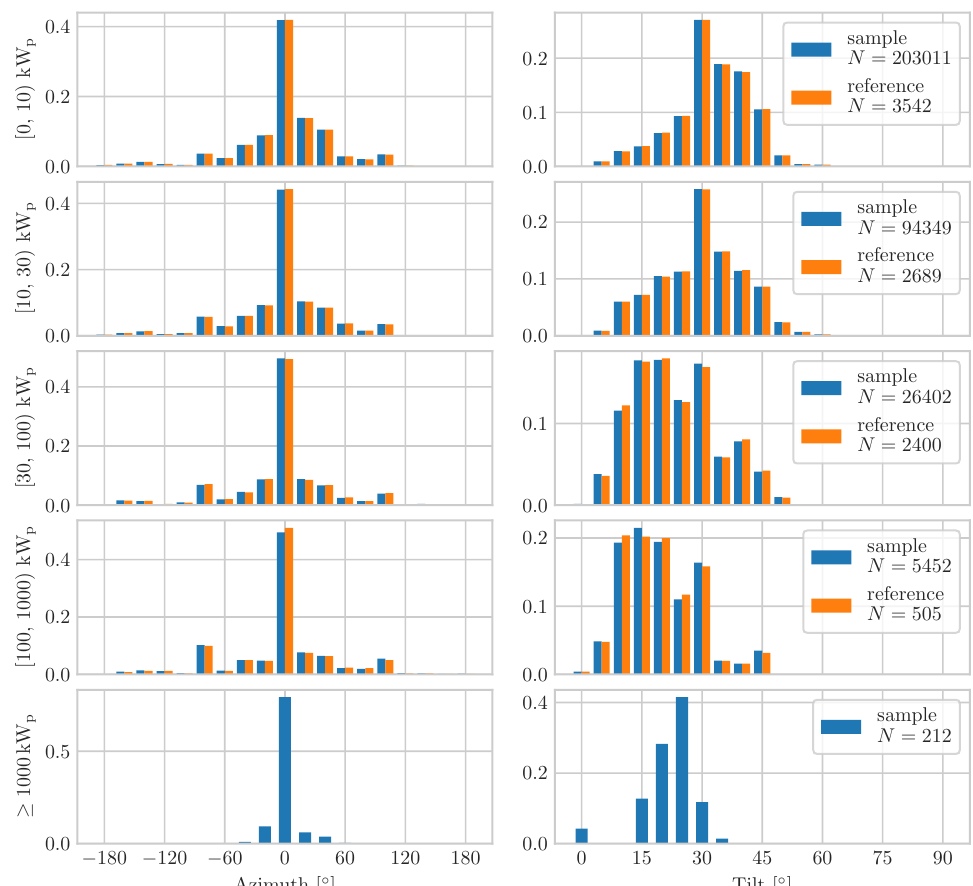
Figure 1. Distributions of azimuth ( left ) and tilt angles ( right ) of the PV systems to be simulated (in blue) and reference systems (in orange) by nominal power classes. In the legend, both the numbers N of the sampled PV systems to be simulated and the reference systems for each class are given. The tilt angles for smaller systems often take high values (steeper roof inclinations of smaller residential buildings), low values for medium-sized systems (flatter roof inclination of large commercial buildings and rack mounting on flat roofs) and intermediate values for large systems (optimised for maximum energy yield). The azimuth angles are increasingly concentrated to the south as the nominal power increases (transition from available roof orientations to yield-optimised south